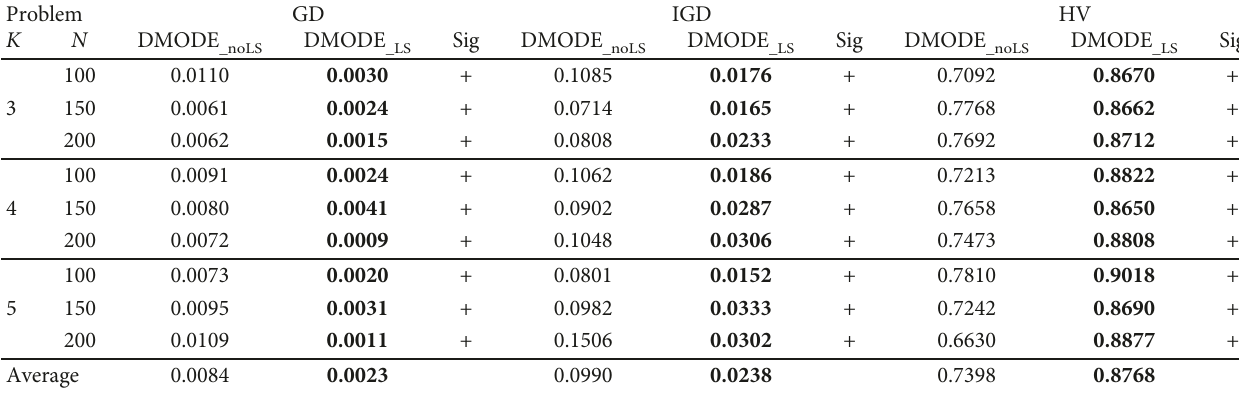
Table 2: Performance metric (GD, IGD, and HV) analysis of the multiobjective local